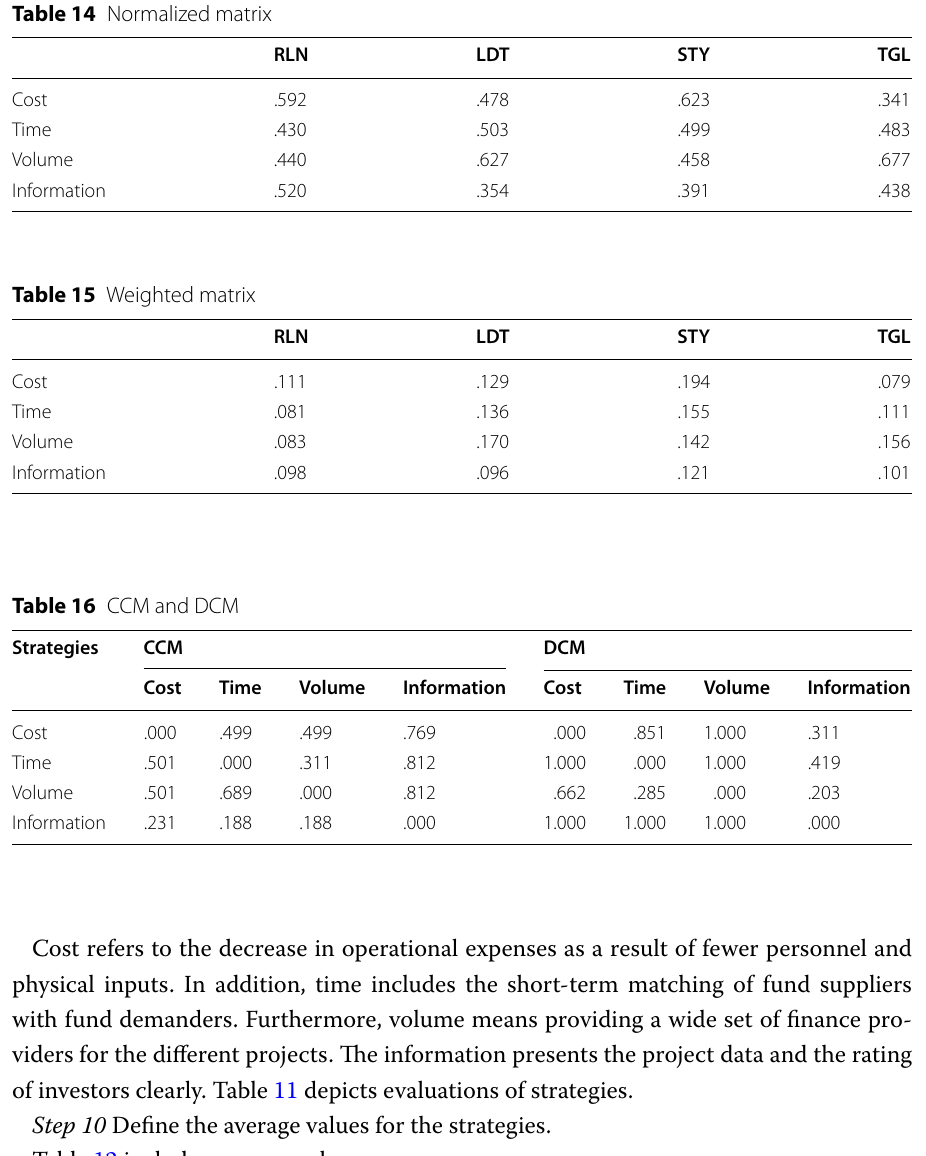
Table 13 calculates the score function values of the strategies. Step 12 Normalize the decision matrix.